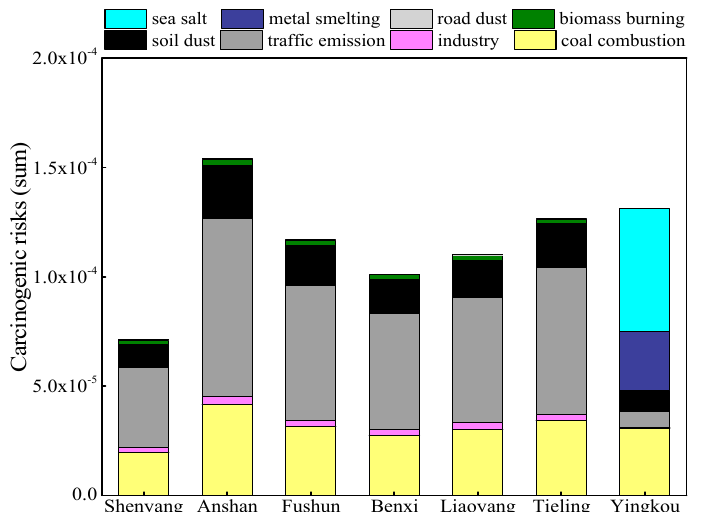
Figure 8. Carcinogenic risks from the PMF ‐ identified sources to PM 2.5 in seven cities. While the first six cities share the same source, Yingkou is different from them.